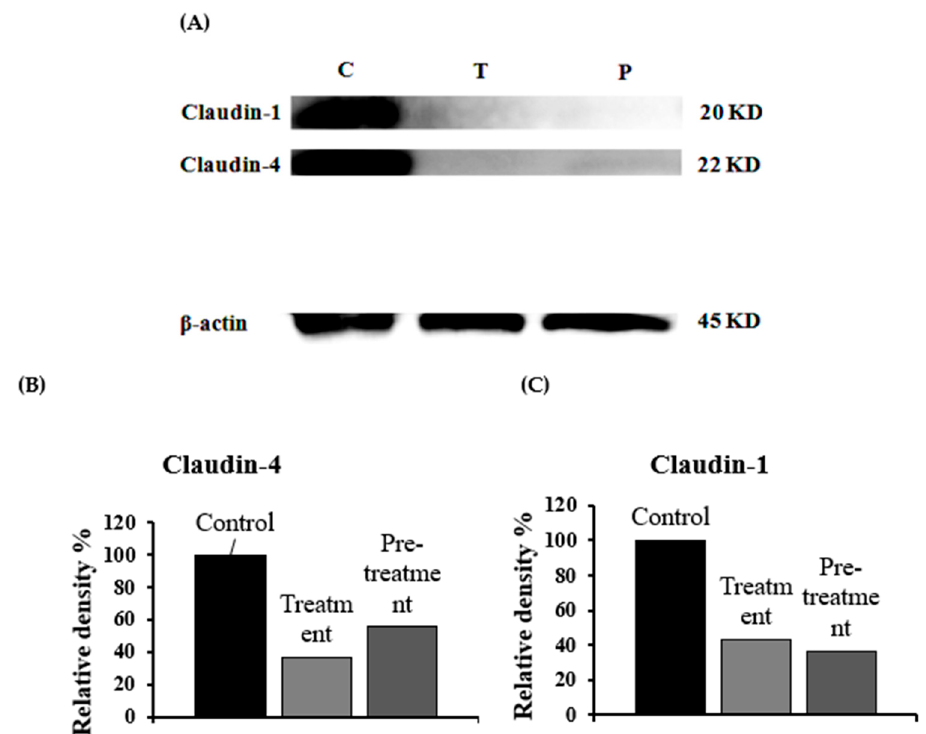
Figure 7. Western blot images of claudin-1 and claudin-4 ( A ): The expression levels of claudin-1 ( B ) and claudin-4 ( C ) in the rat small intestine were quantitatively calculated after a treatment with 0.5% ( v / v ) SLG-30 for 1 h. Control, without treatment; treatment, treatment with 0.5% ( v / v ) SLG-30 for 1 h; and pretreatment, pretreatment for 1 h. The proteins were extracted after 4 h.